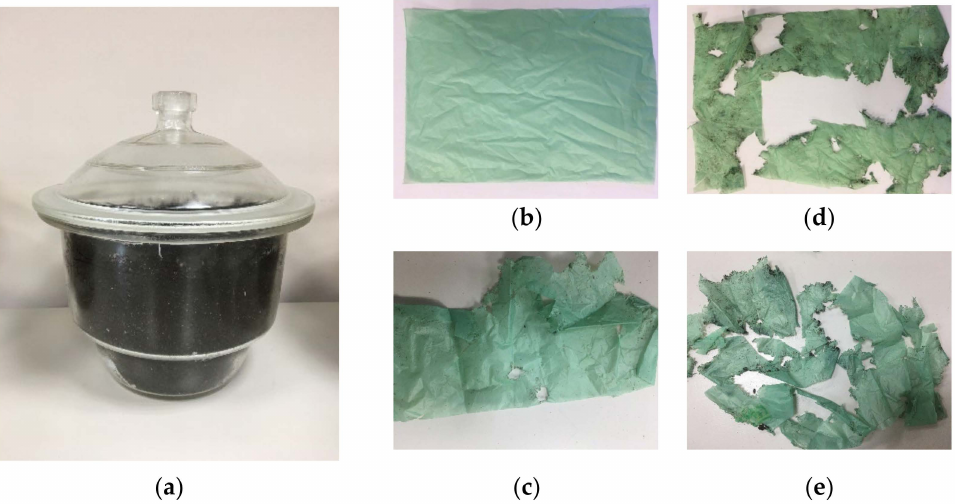
Figure 3. PLA/PBAT-based biodegradable film samples in compost: ( a ) the compost chamber, ( b ) the PLA/PBAT sample before the test, ( c ) the PLA/PBAT sample after soil storage for 90 days, ( d ) the PLA/PBAT sample after soil storage for 180 days, ( e ) the PLA/PBAT sample after soil storage for 365 days.